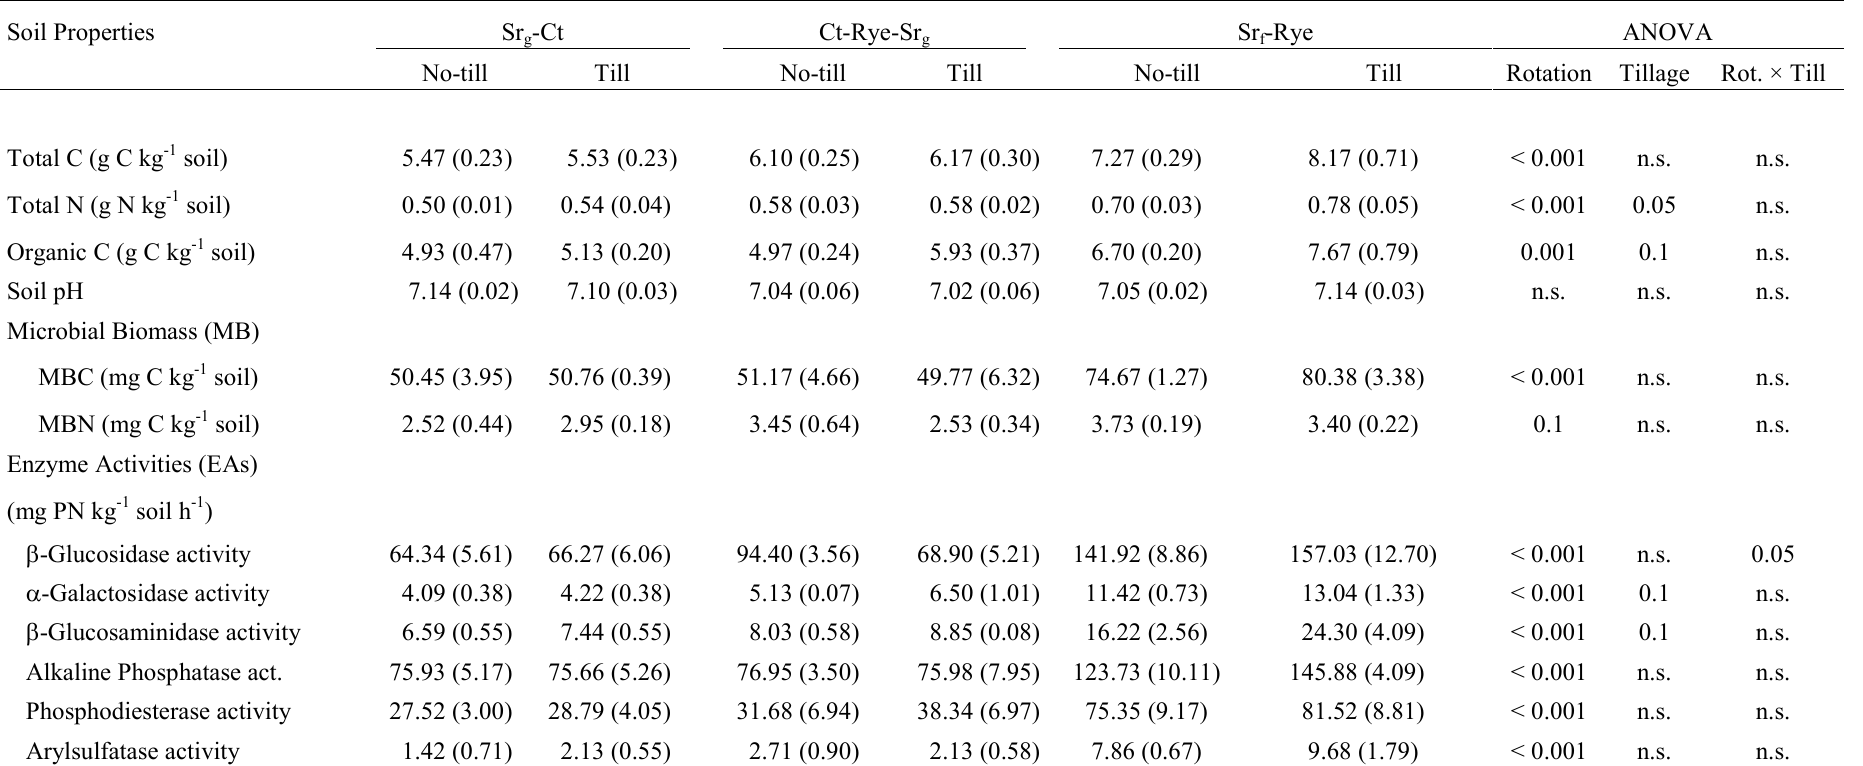
Table 1. Selected soil properties as affected by dryland cropping systems and tillage in a semiarid sandy